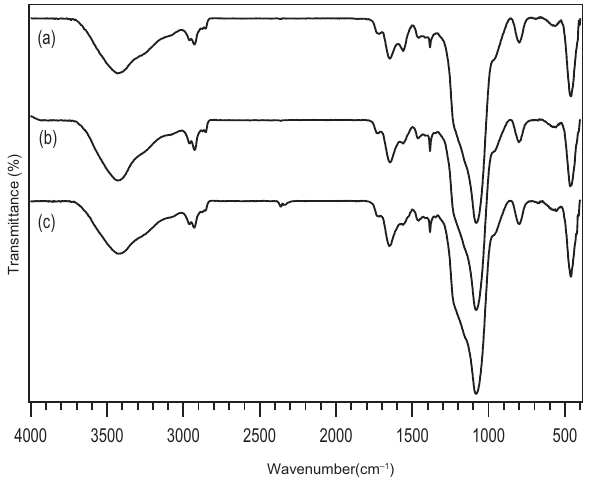
Figure 2: FT-IR spectra of the recycled catalyst after: (a) first run, (b) second run, and (c) third